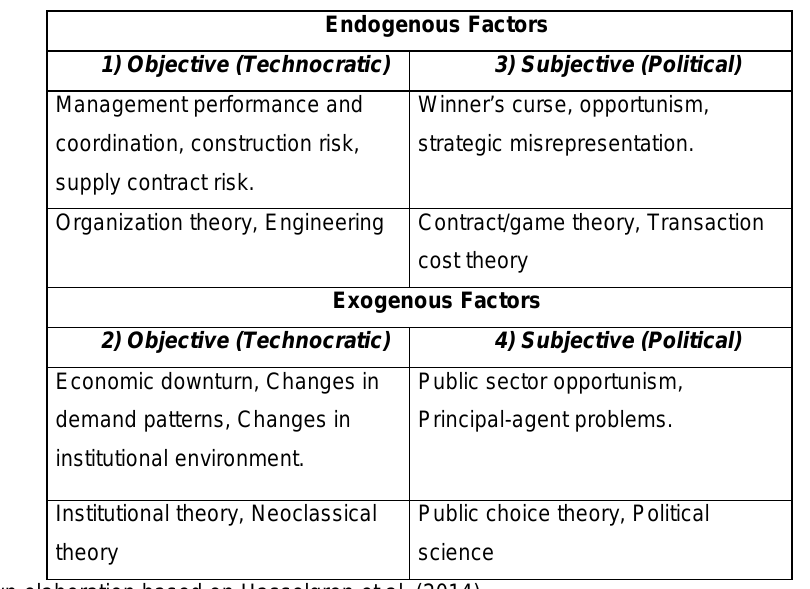
Table 1 . Causes of renegotiation - Four different